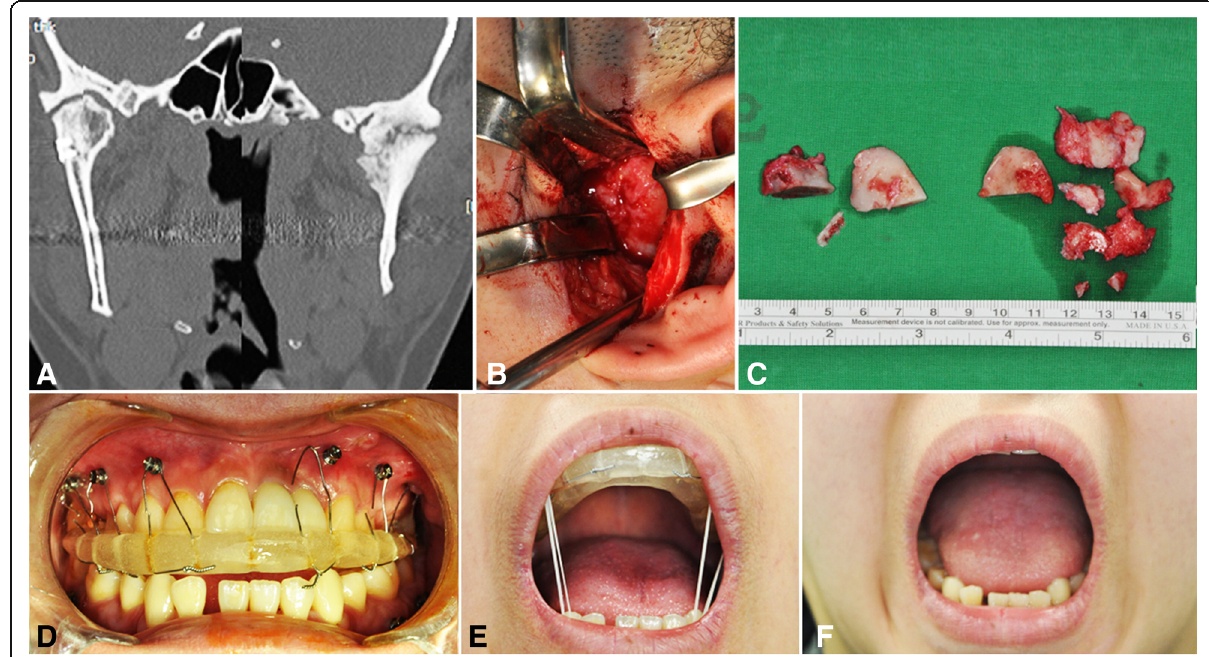
Fig. 1 A 23-year-old female, bilateral TMJ ankylosis secondary to trauma, showing coronal CT scan ( a ), endaural approach with ankylosed mass resection at the left condyle ( b ), resected coronoid process and ankylosed bony mass from both sides ( c ), interocclusal splint retained on the maxillary screws ( d ), active mouth opening exercise with maximal interincisal opening ( e ), and mouth opening appearance after 6 years ( f